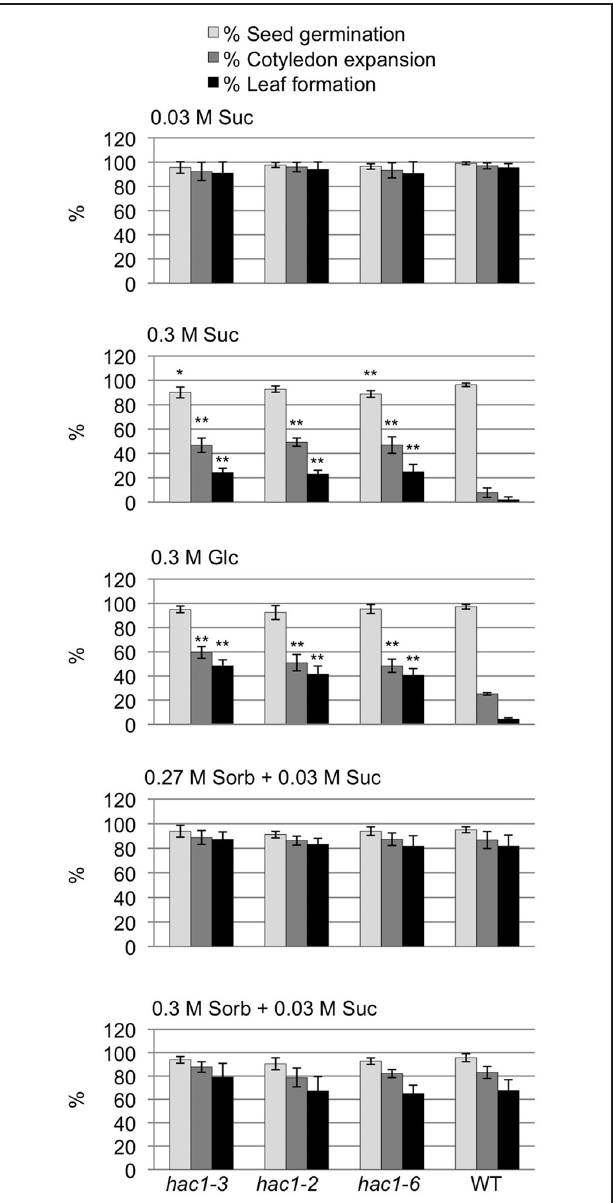
FIGURE 3 | The hac1 mutants are resistant to the inhibitory effects of high concentrations of exogenous sugars on early seedling development. Mutant and wild-type Col-0 (WT) seeds were surface sterilized and then incubated in the dark at 4 ◦ C for 3 days prior to being sown on solid Arabidopsis minimal media supplemented with the indicated additive. After an additional 14 days in the light at room temperature, seeds were scored to determine the percentages of seeds that had germinated, formed expanded cotyledons and developed true leaves. Error bars indicate standard deviations. Mutant and wild-type results differed with: ∗ p < 0 . 05; or ∗∗ p < 0 . 01, according to a Student’s t -test. N = 4.